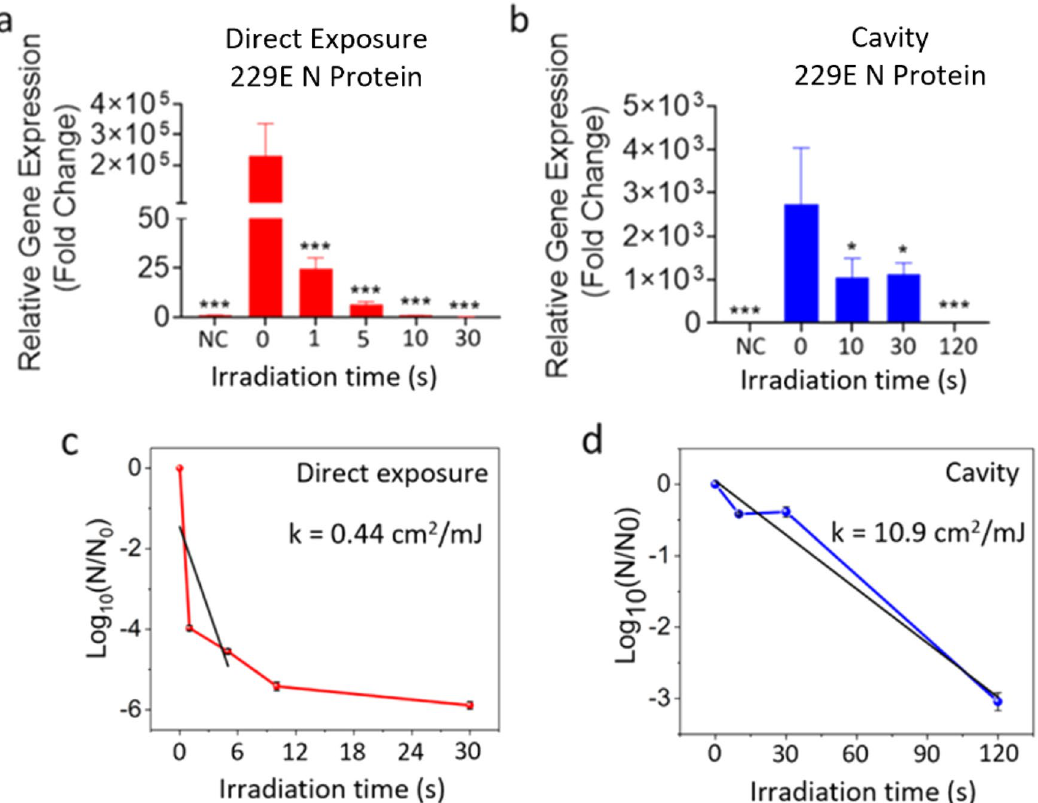
Figure 2. HCoV-229E virus was exposed to direct pulsed UVC laser ( a ) and cavity ( b ) for the indicated times. Calu-3 cells were treated 24 h after seeding with the indicated groups of 229E (3 MOI). At 72 h post-infection RNA was extracted and qPCR performed. Average fold change ± SEM, compared to the negative control (NC), is shown (N = 3). A 1-Way ANOVA and Dunnett’s post hoc test was used to determine significance compared to 0 s. HCoV-229E survival as a function of UV irradiation time via direct exposure ( c ) and cavity ( d ). * p < 0.05, ** p < 0.01, *** P < 0.001, **** P <